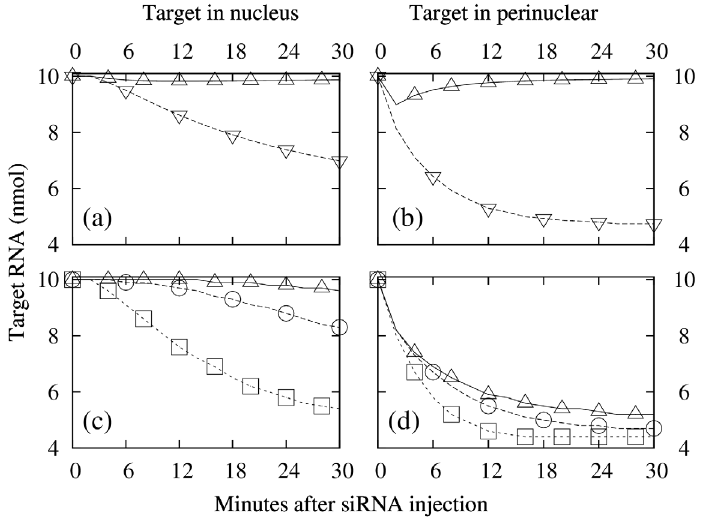
Fig 1. Time-evolution of target RNA concentration. (a) Average density, target in nucleus: 4 , p d = 0, s d = 1; 5 , p d = 0.4, s d = 0.6. (b) Same as (a), but with target in perinuclear region. (c) Target in nucleus at 0.29 R ( 4 ), 0.35 R ( (cid:3) ), and 0.42 R ( ☐ ); p d = 0.4 and s d = 0.6; cell radius is R = 10 μ M; nucleus-cytoplasm boundary is at 0.45 R . (d) Same as (c), but target in perinuclear region at 0.48 R , 0.55 R , and 0.61 R .